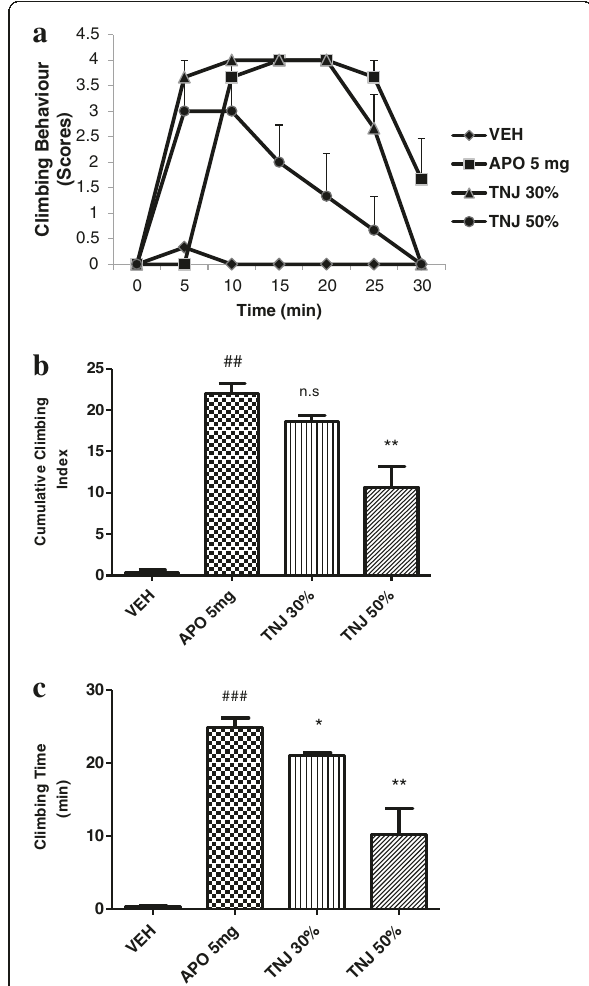
Figure 3 Effect of TNJ, (% v/v, 21 days in the drinking water) on cage climbing behaviour and climbing time induced by apomorphine in mice. ( a ) Each point represents the mean ± SEM from the scores obtained from six animals. ( b ) The cumulative scores were measured for 30 min after administration of apomorphine. ( c ) Total time spent on the wall of the cage. ### p < 0.001, ## p < 0.01 compared with that of the saline group; * p< 0.05, ** p < 0.01, *** p <0.001 compared with that of the apomorphine (APO, mg/kg, i.p) group . n.s- not significant. in mice Pre-treatment with MMC (1, 3, 5 g/kg, p.o) significantly (p<0.0001) inhibited methamphetamine-induced stereo- typy behaviour in a dose-dependent manner (Figure 4a and b). It also significantly [ F ( 4 , 25 ) = 7.535; P < 0 . 01] attenuated methamphetamine-induced climbing time in mice (Figure 4c). Haloperidol (2 mg/kg, i.p) completely reversed the methamphetamine-induced stereotypy and climbing time in mice (data not shown).